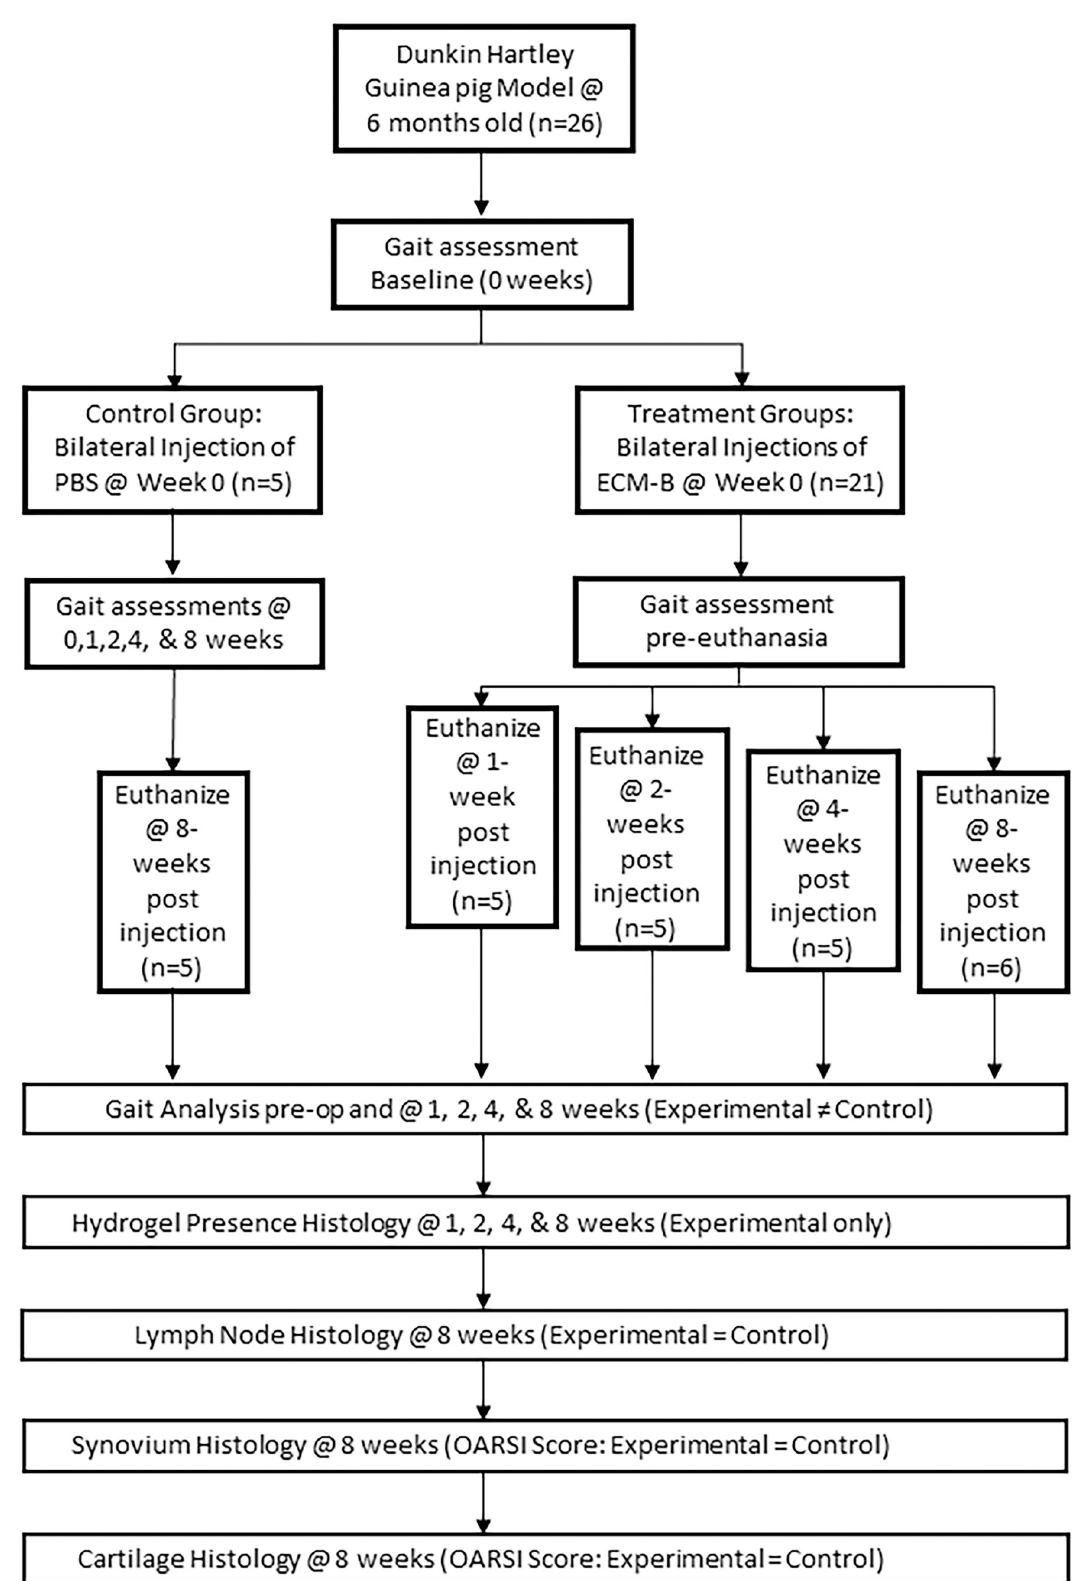
Fig 1. Schematic of experimental